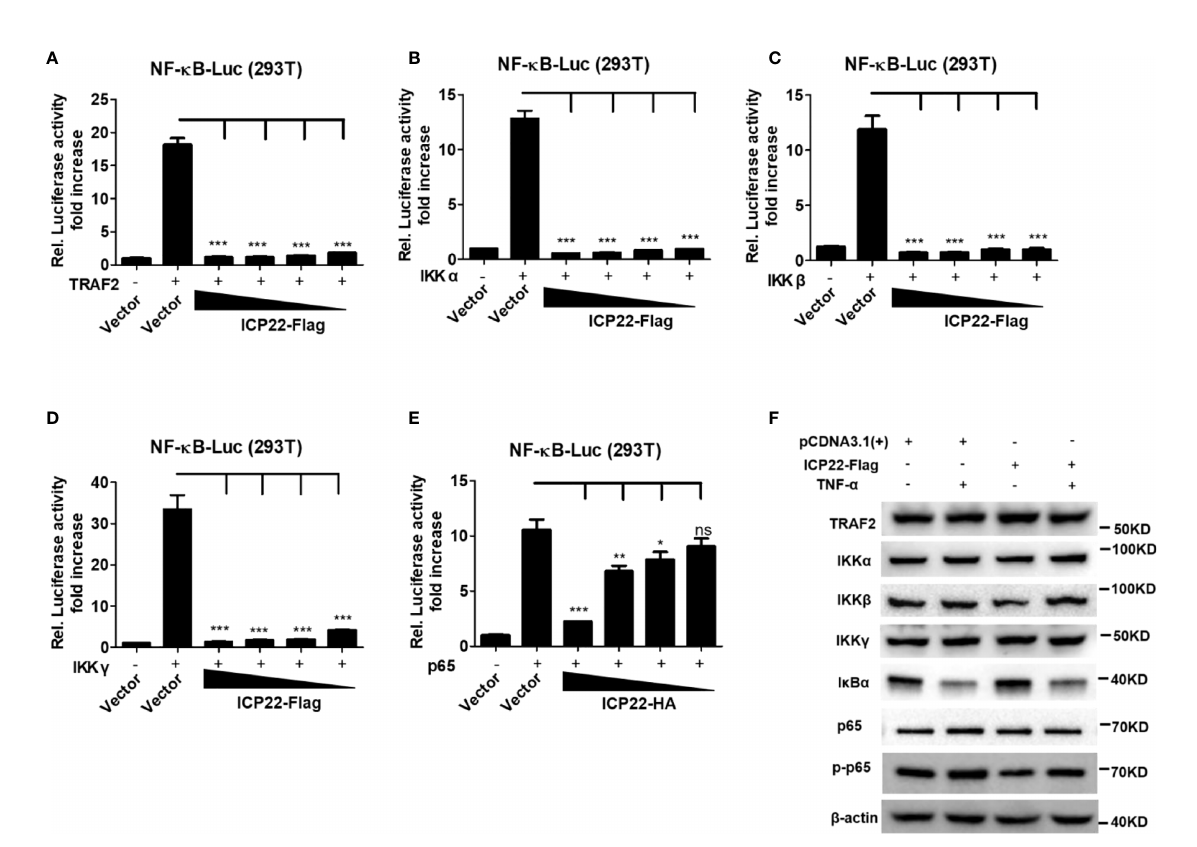
FIGURE 3 HSV-2 ICP22 inhibits NF- k B activation by acting on the downstream of p65. (A – E) . HSV-2 ICP22 inhibits TRAF2, IKK a , IKK b , IKK g and p65- induced NF- k B activation. HEK 293T cells were seeded in 24 well plates overnight and co-transfected with the reporter plasmids pNF- k B-Luc and phRL-TK, and plasmid expressing TRAF2, IKK a , IKK b , IKK g or p65, together with empty vector or ICP22-expressing plasmid. At 30 h post- transfection, the reporter activities were determined by DLR assay. (F) . HSV-2 ICP22 has no effect on the expression of TRAF2, IKK a , IKK b , IKK g and p65 or degradation of I k B a . HEK 293T cells were seeded in 6 well plates overnight and transfected with plasmid expressing ICP22 or empty vector. At 24 h post-transfection, cells were stimulated with or without TNF- a (20 ng/ml) for 6 h. The expressions of TRAF2, IKK a , IKK b , IKK g , I k B a , p65 and phospho-p65 were detected by western blot. For graphs, data shown are mean ± SD of three independent experiments with each condition performed in triplicate. For images, one representative experiment out of three is shown. *p<0.05, **p<0.01, ***p<0.001, ns, not signi fi